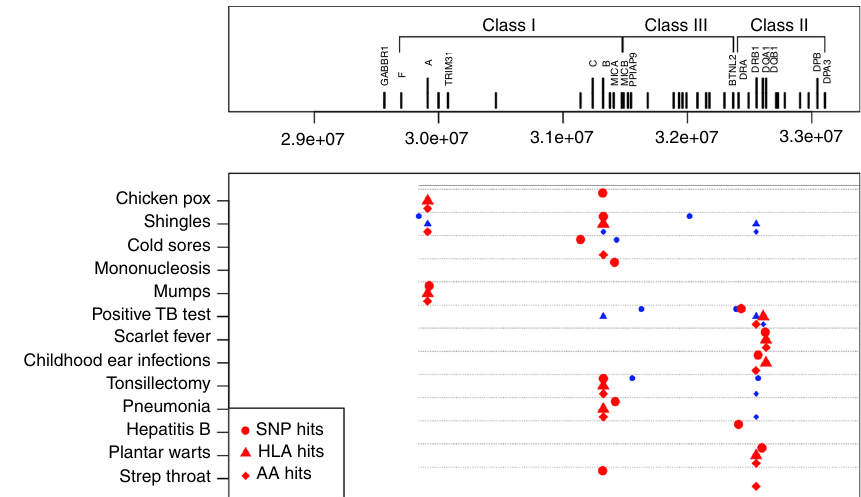
Fig. 1 Summary of independent HLA signals. The strongest associated signals ( red ) and putative independent secondary signals ( blue ) are shown for each disease along with their location within the region. Independent secondary signals were de fi ned as those with residual conditional association using the same signi fi cant threshold as the primary association signal mentioned in the main